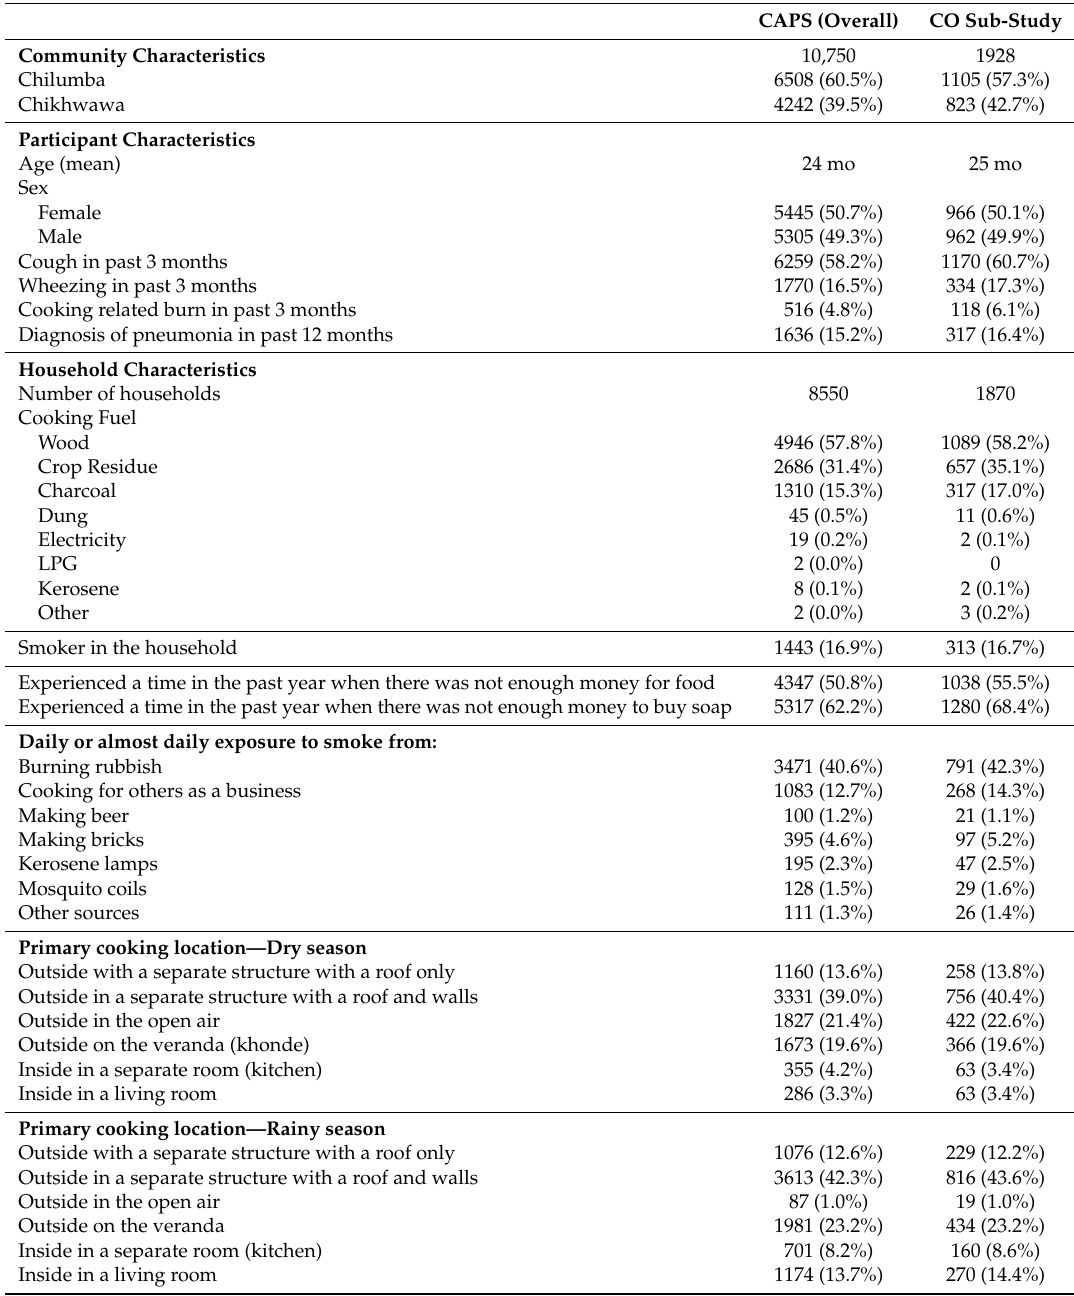
Table 1. Baseline